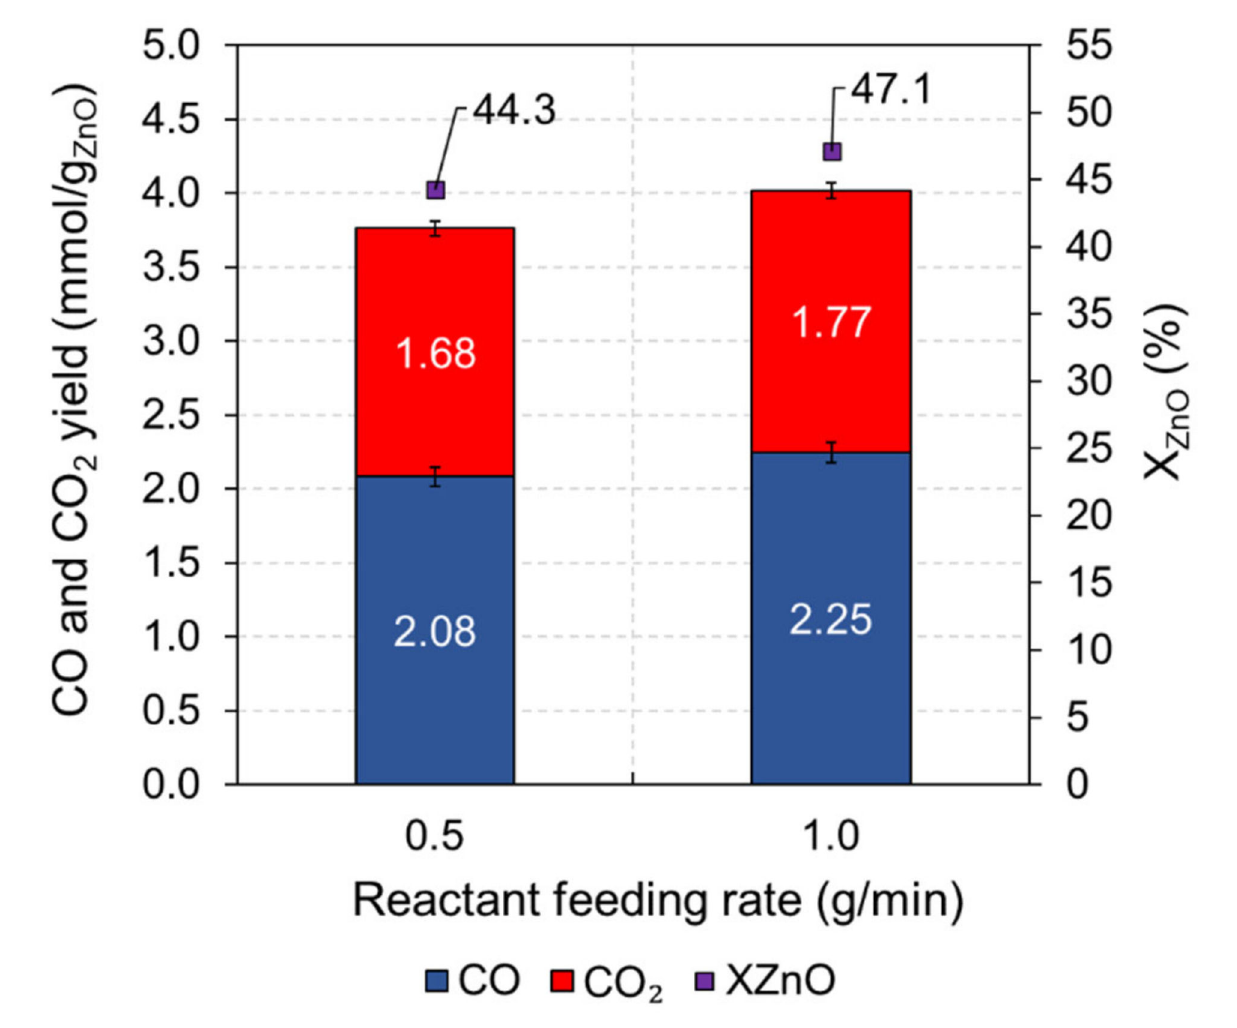
Figure 9. CO and CO 2 yields, along with ZnO conversion ( X ZnO ) for ZnO carbothermal reduction (CB/ZnO = 1.5) during continuous powder